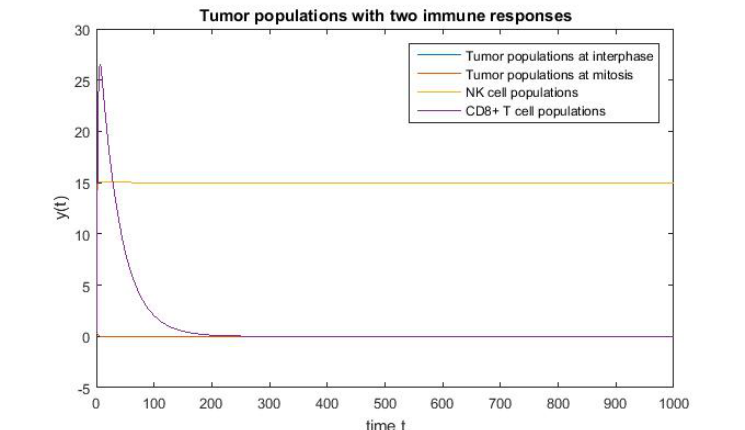
Figure 4. Tumour population with two immune response in the absence of delay at the fixed point E 0 = ( 0,0,15,0 )